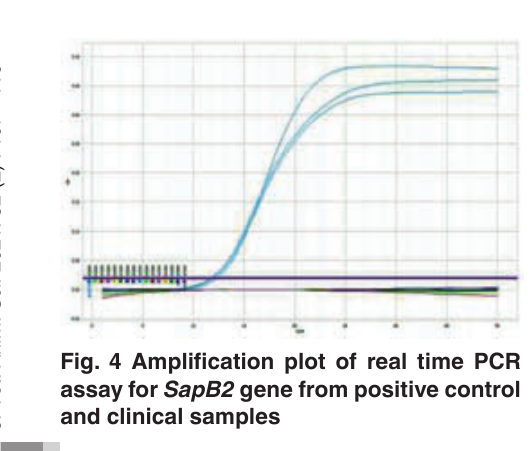
Fig. 4 Amplification plot of real time PCR assay for SapB2 gene from positive control and clinical samples